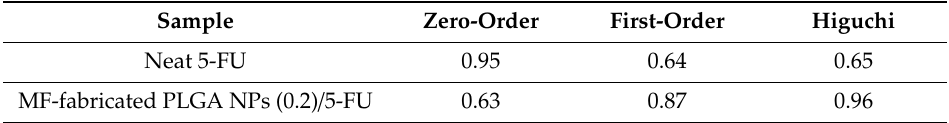
Table 2. Regression coe ffi cients of di ff erent mathematical models fitted to the release of 5-FU in the neat form and from MF-fabricated PLGA NPs [0.2 (% w / v